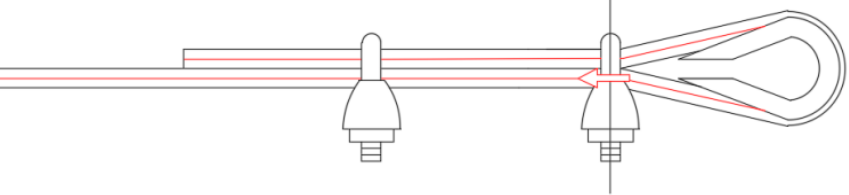
Figure 25. Eccentricity of the load provided by a clip to the steel wire rope, with respect to the Flemish eye.